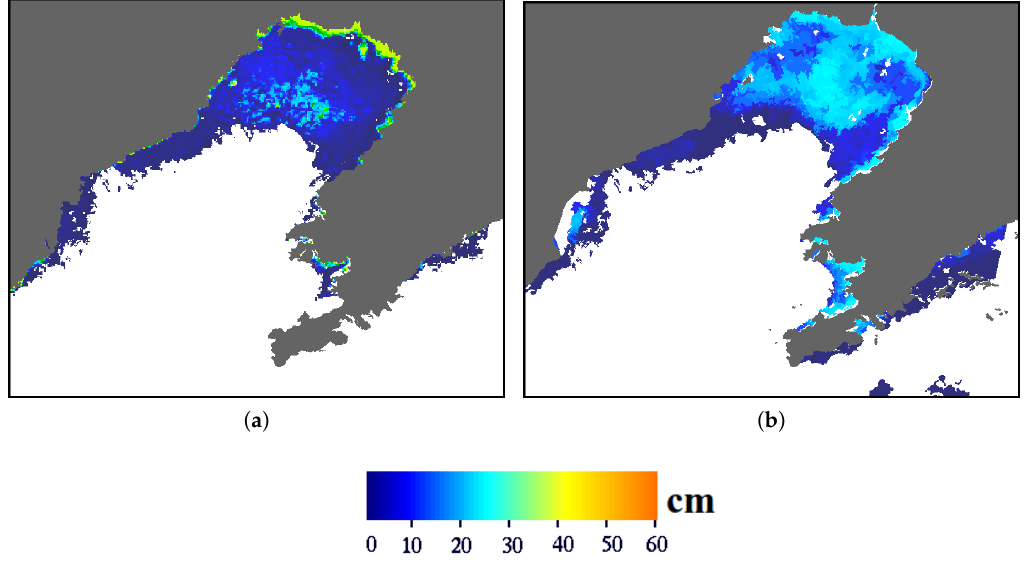
Figure 20. Ice thickness based ( a ) on MODIS and ( b ) on SAR, January 9 2013. Cloud contaminated areas have been